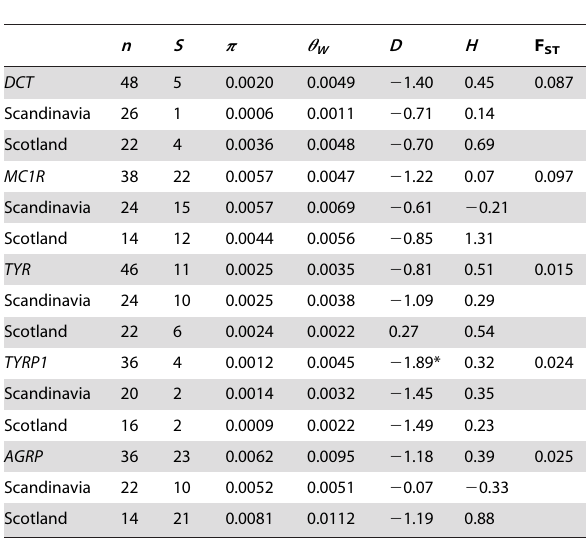
Table 1. Summary statistics of genetic variation and statistical tests of neutrality for phased sequence data used in the